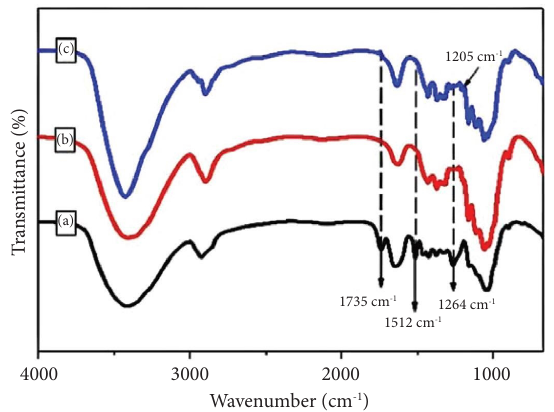
Figure 4: Te OPEFB FTIR spectrum of (a) groundnut shell with spectral bands losing at 1735cm − 1 , 1512cm − 1 , and 1264cm − 1 ; (b) groundnut shell chemically purifed cellulose with spectral bands at 1432cm − 1 , 1060cm − 1 , and 897cm − 1 ; and (c) groundnut shell cellulose nanocrystal with the sharp and intense spectral bands at 3410 cm − 1 which is showing the disappearing of the noncellulosic components [11]. Copyright and permission from